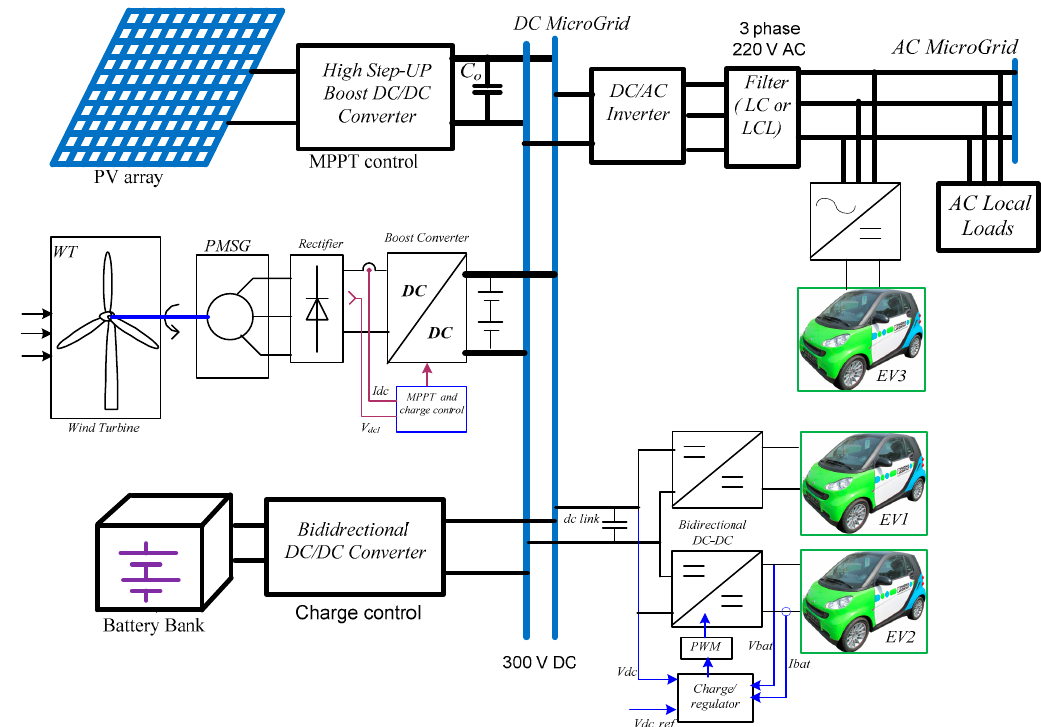
Figure 1. Configuration of the proposed DC microgrid based charging station.